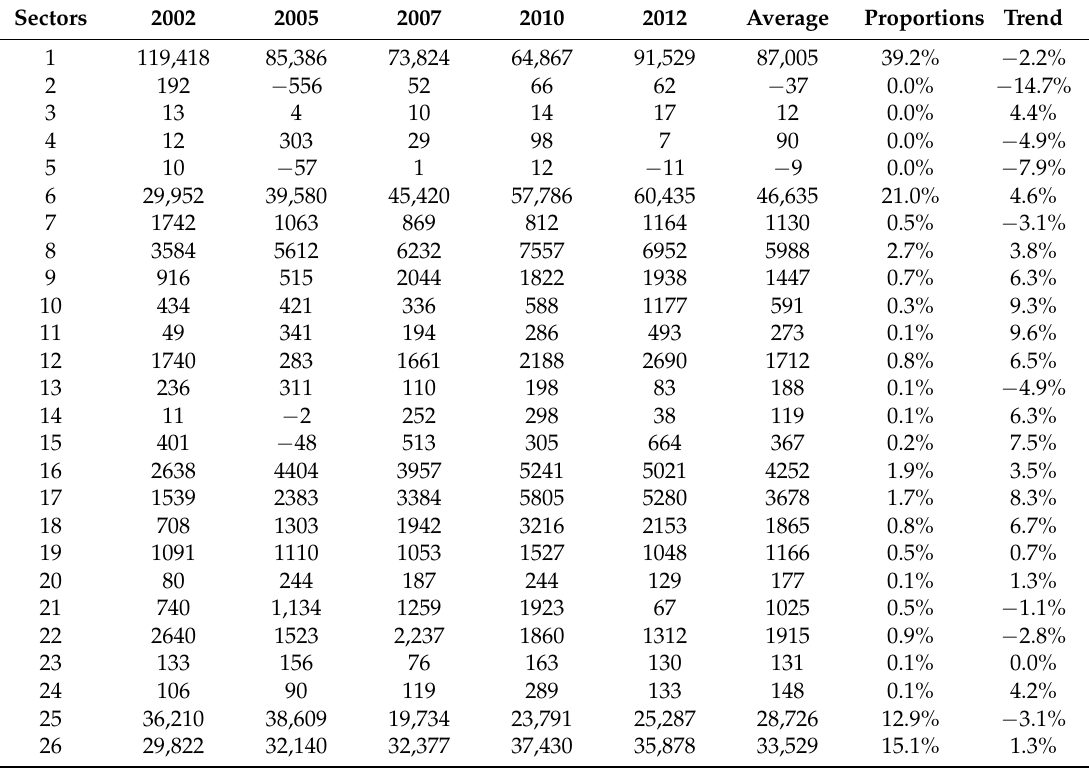
Table 2. Sectoral virtual blue water footprint of China from 2002 to 2012. (unit: million m 3 ).